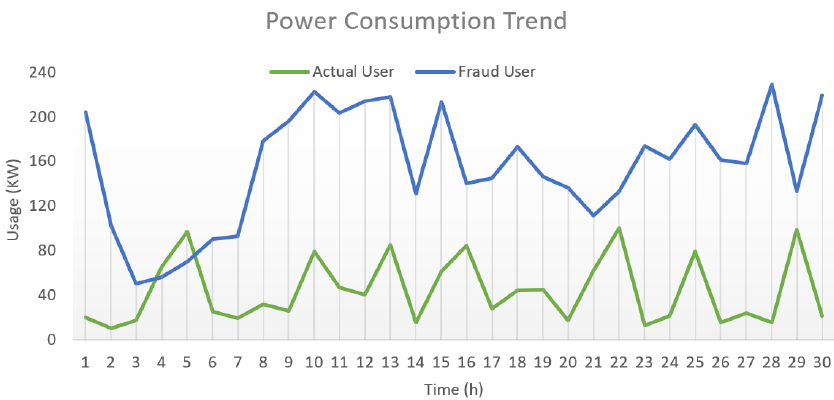
Figure 2. Consumption Patterns for Normal and Theft Users.